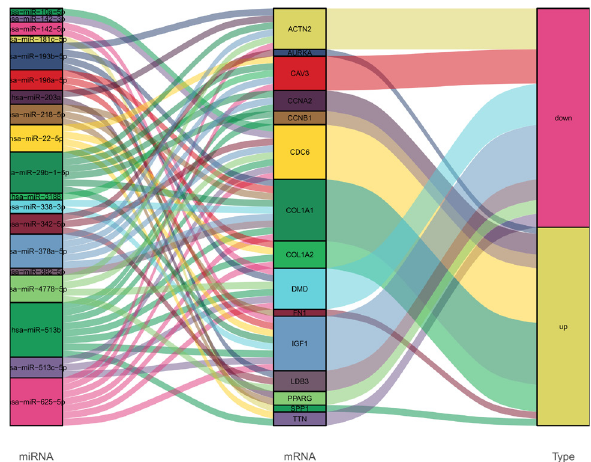
Fig. 4. MiRNA-mRNA regulatory network in OSCC. The first column represented miRNAs, the second column represented mRNAs, the third column represented the expression trend of mRNAs, and the connecting lines between them represented regulatory relationships.